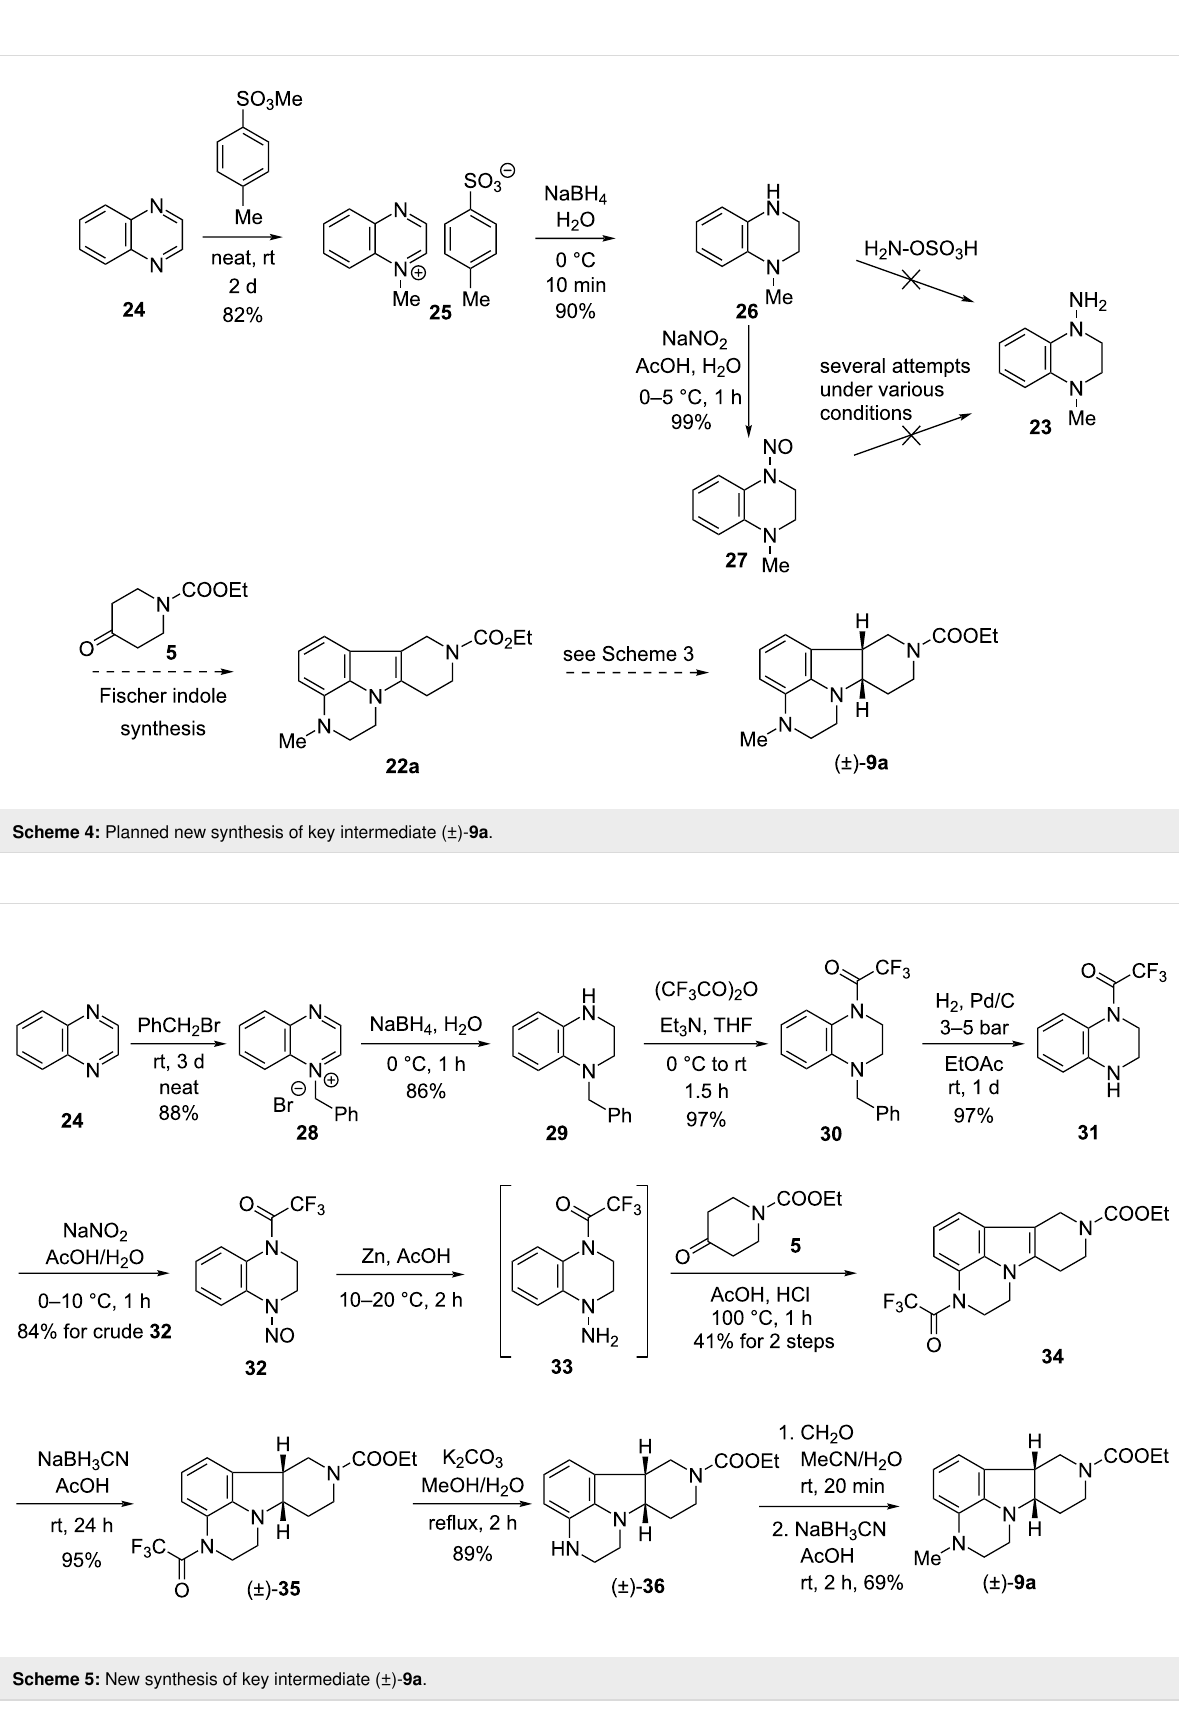
Scheme 5: New synthesis of key intermediate (±)- 9a